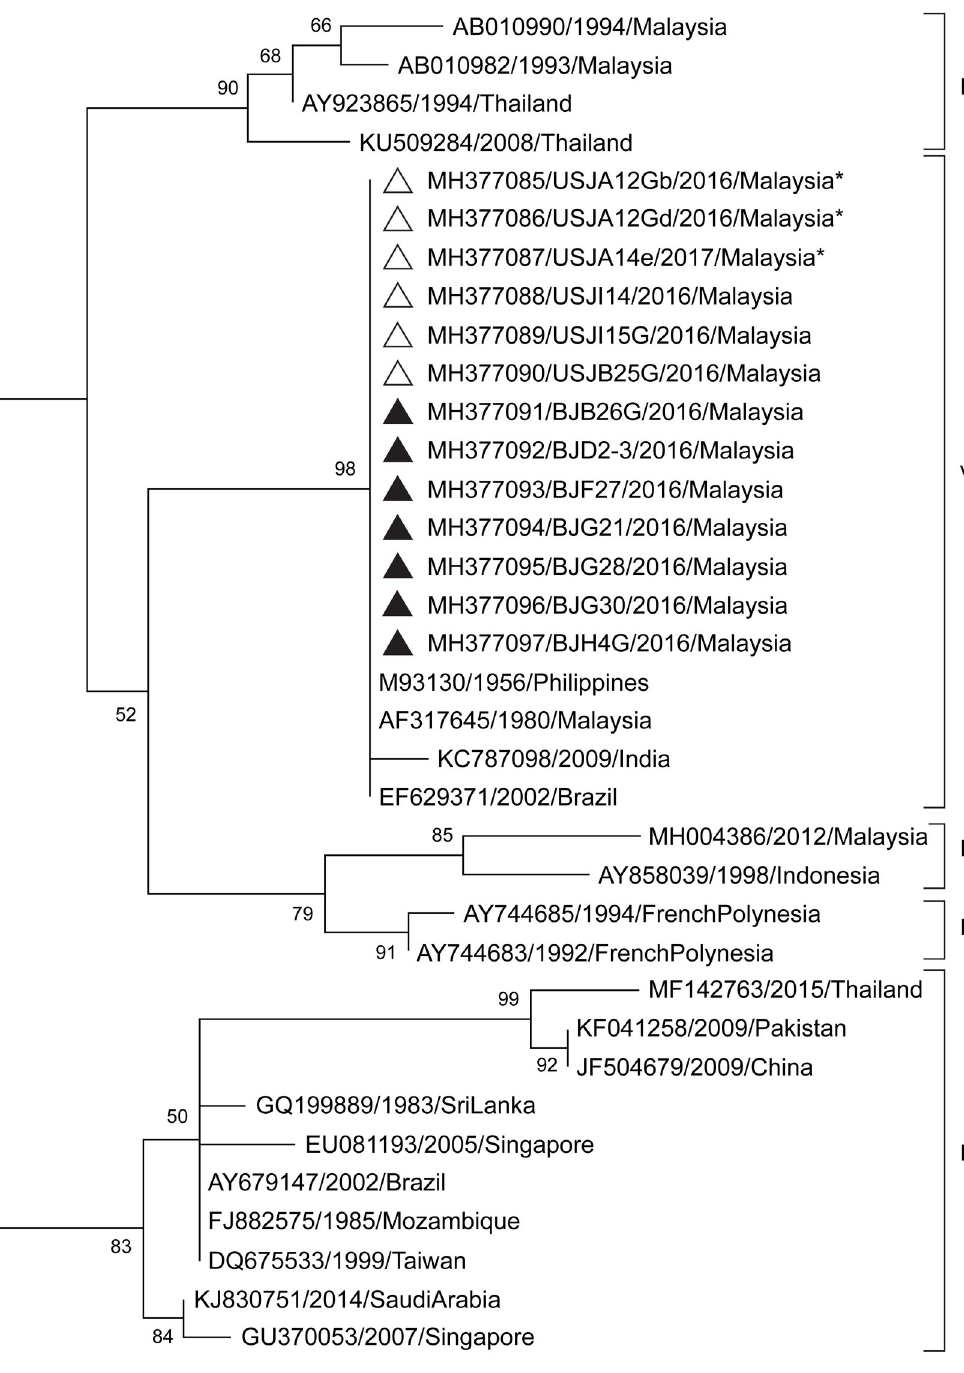
Fig 3. Phylogenetic analysis of the CprM gene sequences of DENV-3 isolates from the Klang Valley. Sample sequences of DENV-3 (240 nt) from Ae . aegypti (indicated with an asterisk � ) and Ae . albopictus collected from Selangor (indicated with a white triangle) and Kuala Lumpur (indicated with a black triangle) in this study are labelled with the GenBank accession number, sample ID and year of collection. Bootstrap values (1,000 replicates) are shown next to the branches. Taxa of reference sequences are labelled as the GenBank accession numbers, year and country of sample